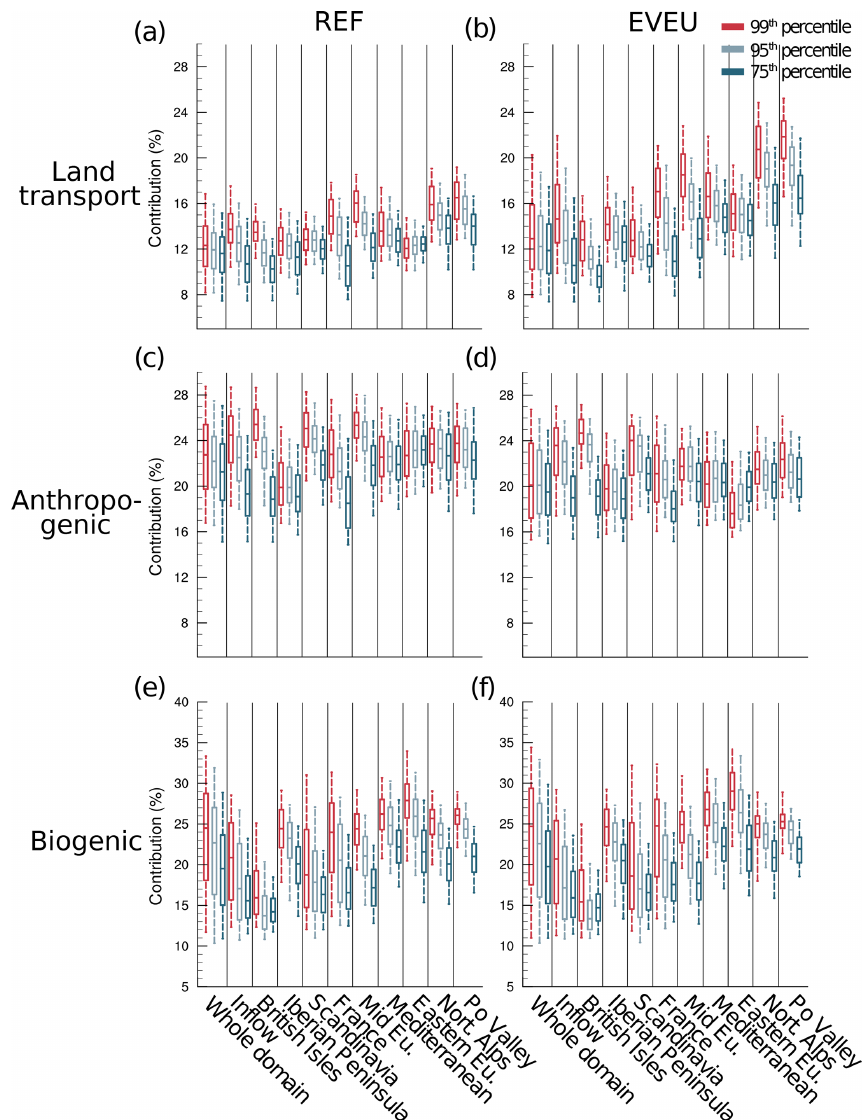
Figure 11. Box-whisker plot showing the contributions of the most important emission sources at the 99th, 95th, and 75th percentiles of ozone as simulated by CM50. For simplicity, only the contributions for land transport, biogenic, and other anthropogenic emissions (anthropogenic non-traffic and aviation) to ground-level ozone (in percent) are shown. Therefore, the contributions do not add up to 100%. Panels (a) and (b) show the relative contribution of O tra ; (c) and (d) the relative contribution of anthropogenic emissions (anthropogenic non-traffic and 3 aviation); and (e) and (f) the relative contribution of O soi . The lower and upper end of the box indicate the 25th and 75th percentile, the bar 3 the median, and the whiskers the 5th and 95th percentile of the contributions of all grid boxes within the indicated region. All values are calculated for JJA of the period 2008 to 2010 and are based on 3-hourly model output. The data are transformed on a regular grid with a resolution of 0 . 5 ◦ × 0 . 5 ◦ to allow for the regional